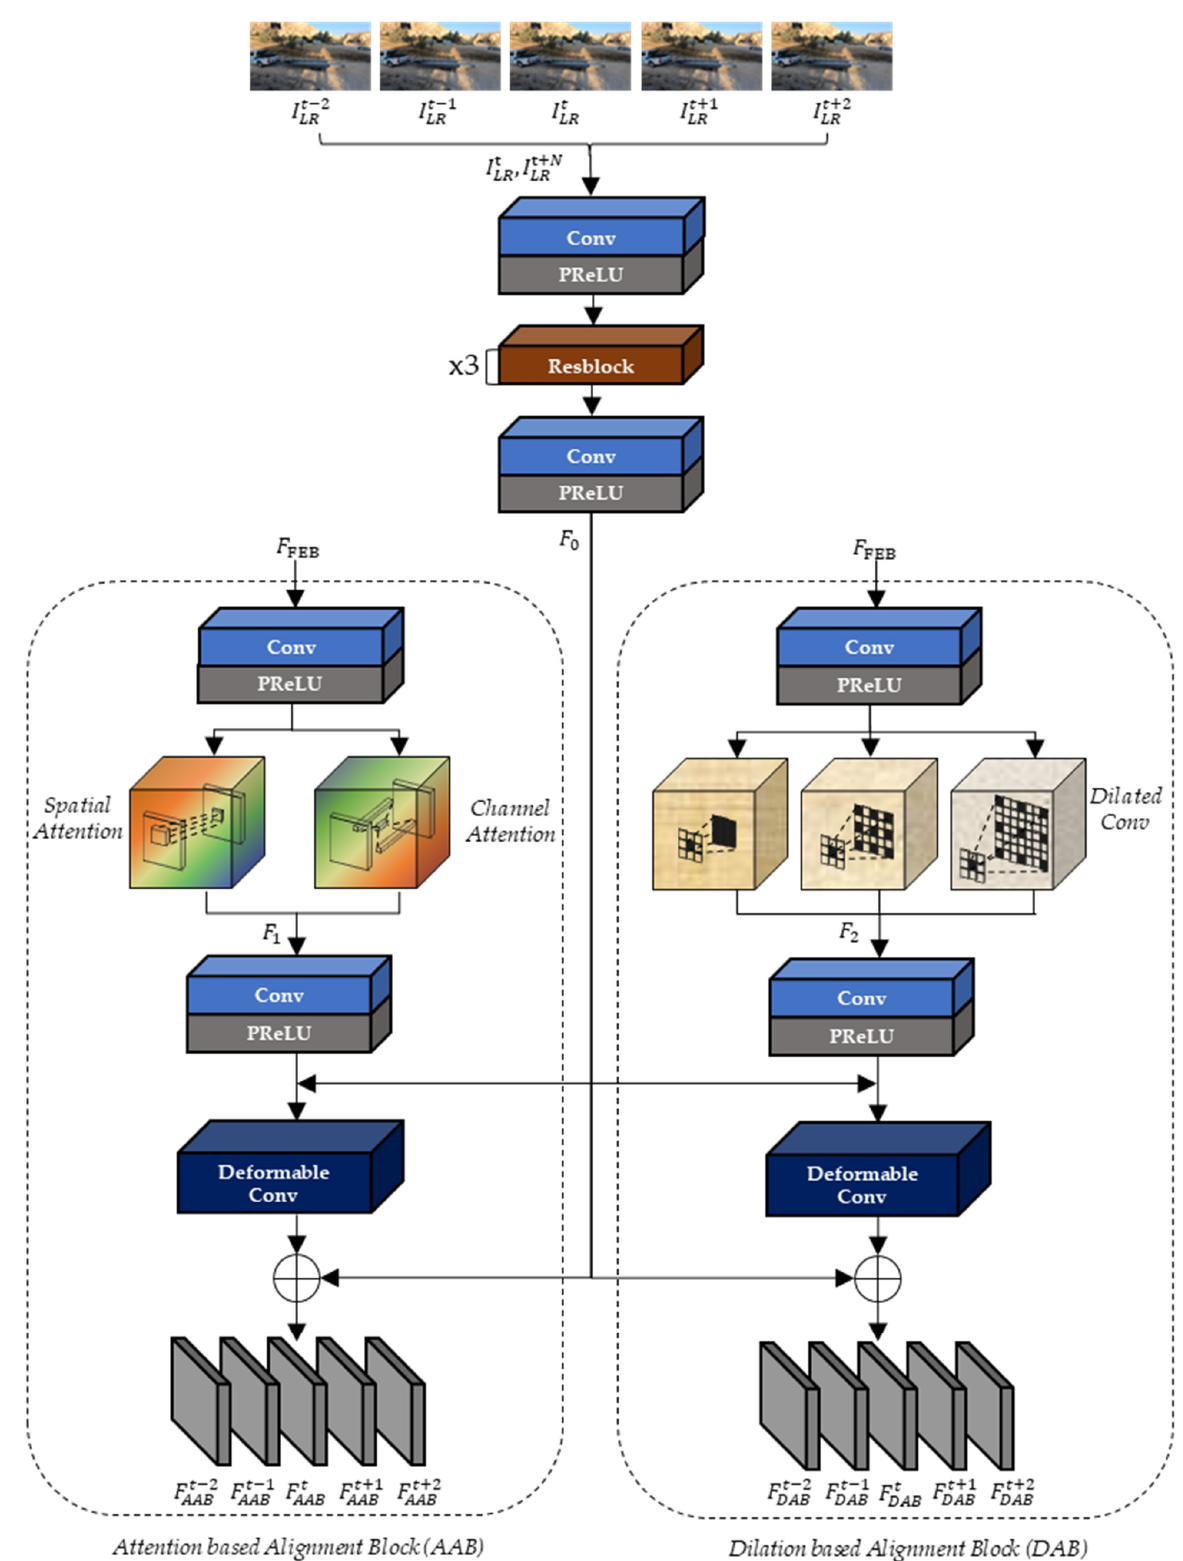
Figure 7. The architecture of alignment blocks.